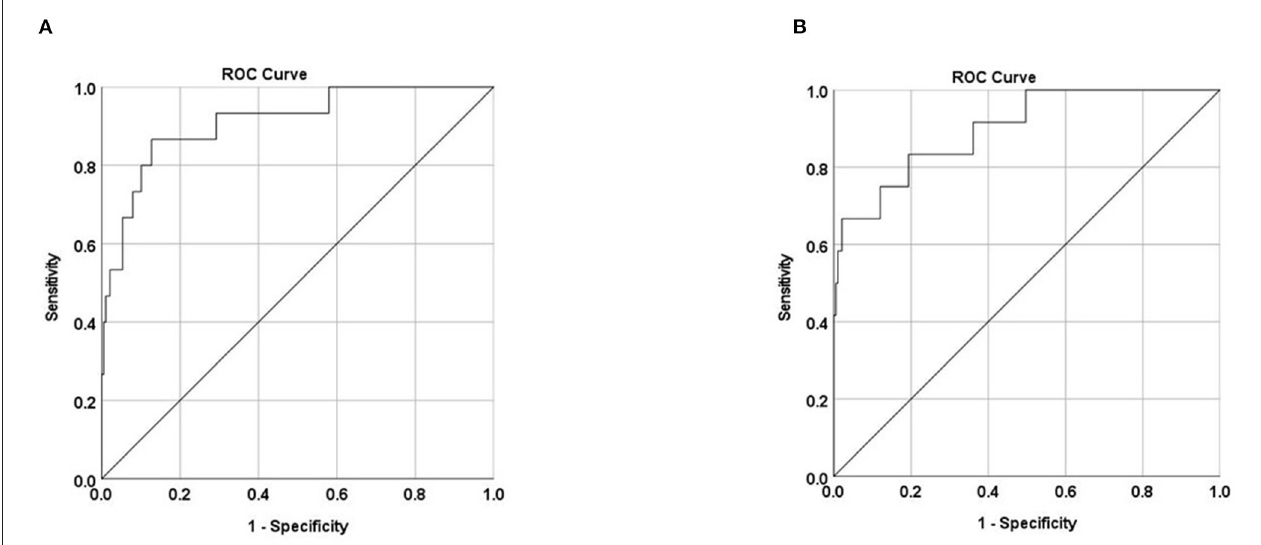
FIGURE 4 | Area under the receiver operating characteristic curve (AUC) of predicting severe disease (A) and critical illness (B) in the validation cohort. AUC = 0.911 (95% CI, 0.832–0.990) and 0.899 (95% CI, 0.806–0.992), respectively.